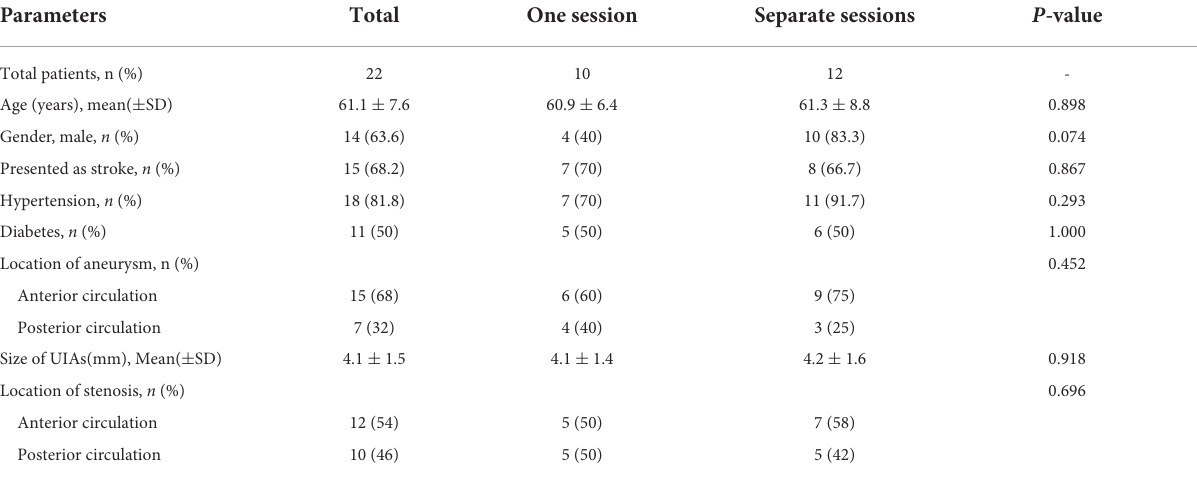
TABLE 2 Comparison of demographics and clinical information between